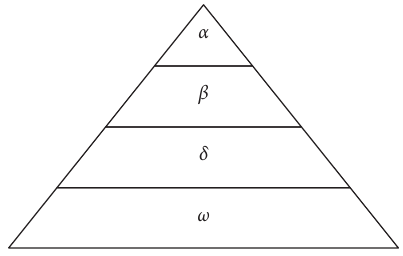
Figure 5: Leadership pyramid with four level ( α , β, δ and ω